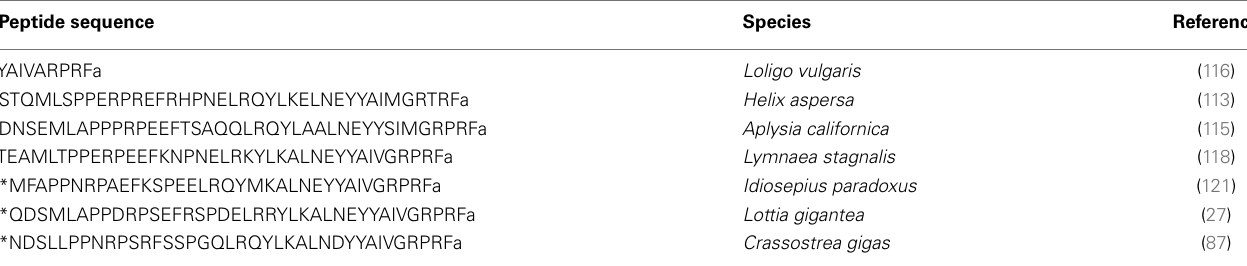
Table 5 | NPF-related peptides